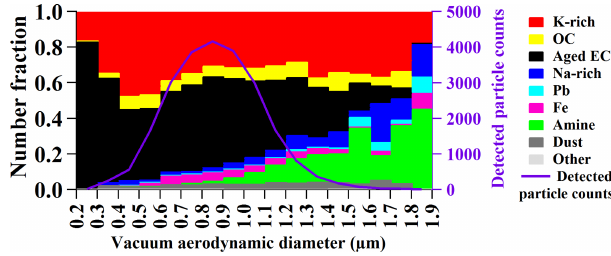
Figure 4. Number fractions for size distribution of the cloud resid- ual types in 100nm size